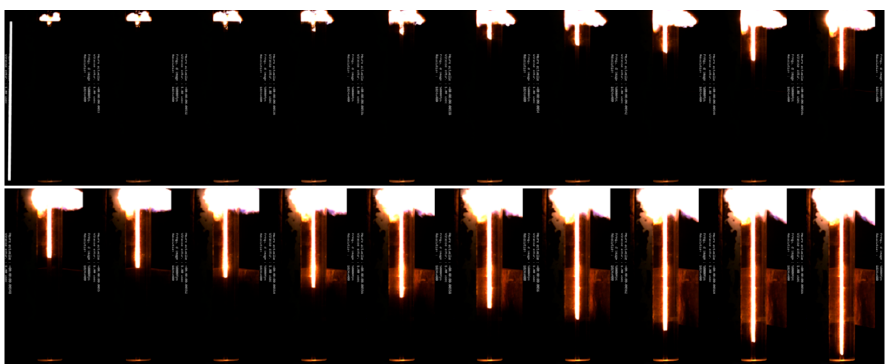
Figure 4. Images captured from the combustion of the Al/In 2 O 3 _nm energetic composite material. The equivalence ratio ( ϕ ) was fixed at 1. The elapsed time between images was 40 µs. The white scale bar (at left on first image) represents the tube length (150 mm).